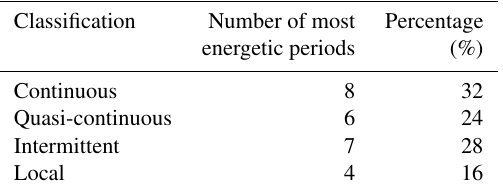
Table 2. Energy distribution classification of the geomagnetic B x component during HILDCAAs.